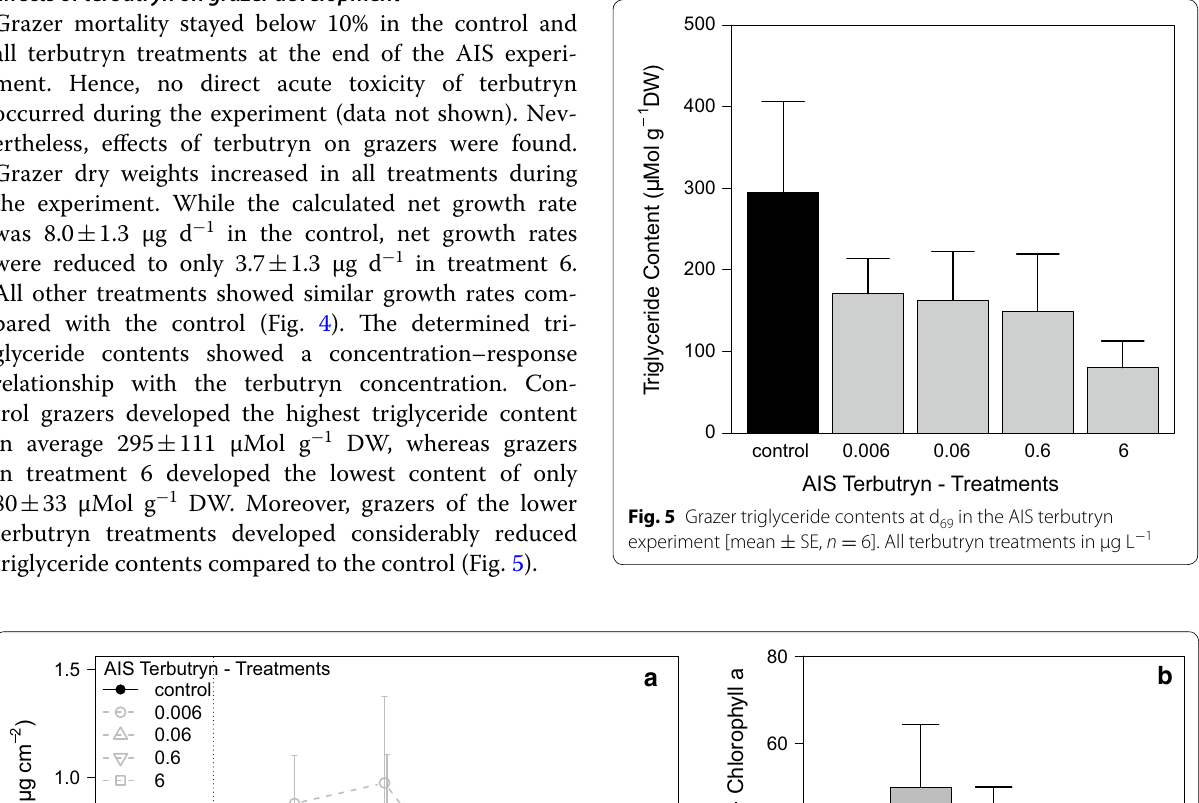
SE, n 6]. d ± = − 15 SE, n 2]. All ± =